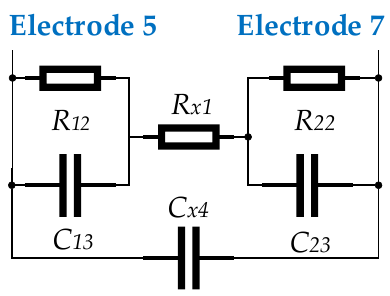
Figure 7. Equivalent circuit composed of electrode and fluid.